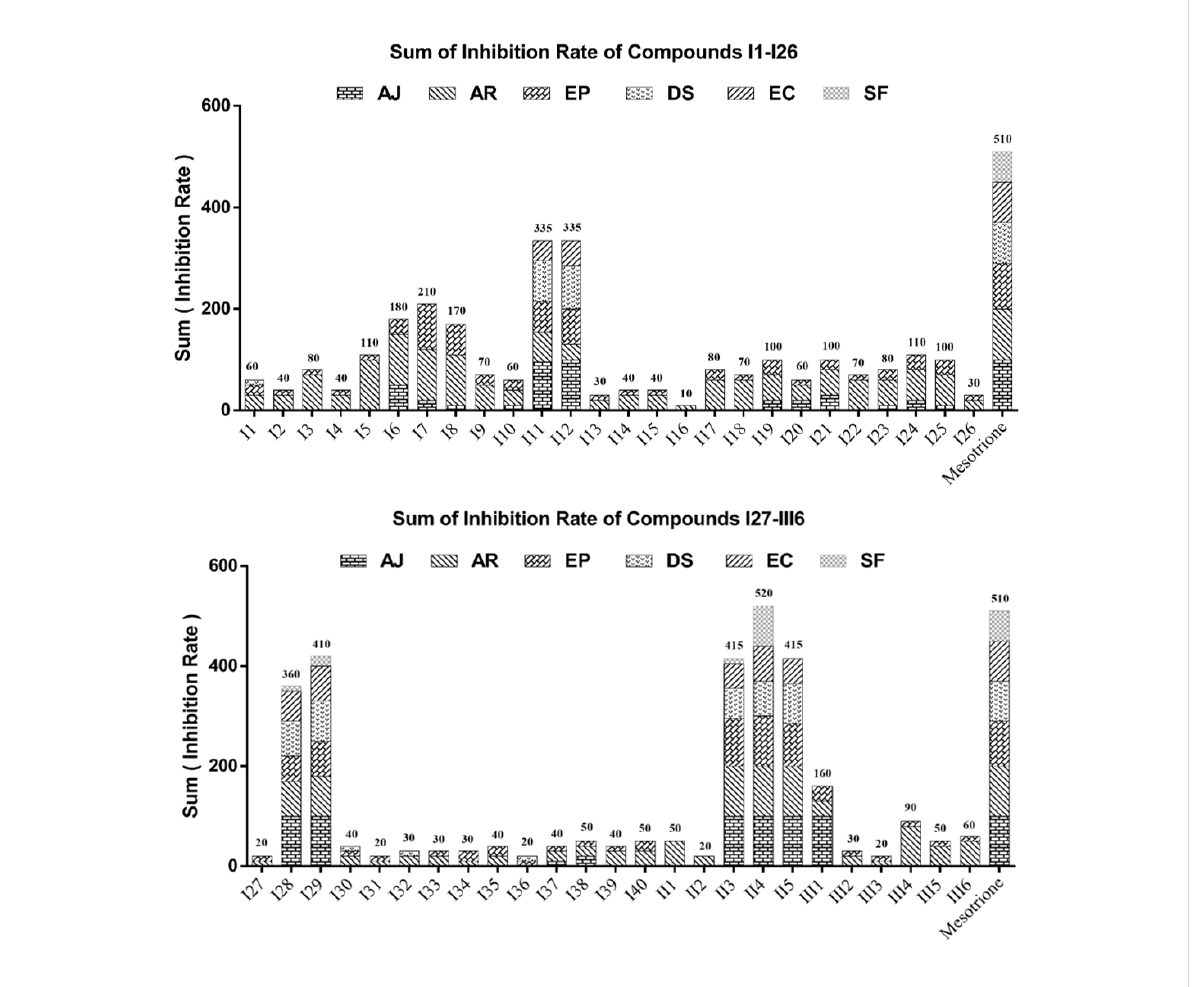
Figure 5: Sum of inhibition rate of title compounds at 150 g ai/ha. (Abbreviations: AJ, Abutilon juncea ; AR, Amaranthus retroflexus ; EP, Eclipta pros- trata ; DS, Digitaria sanguinalis ; EC, Echinochloa crus-galli ; SF, Setaria faberii .)